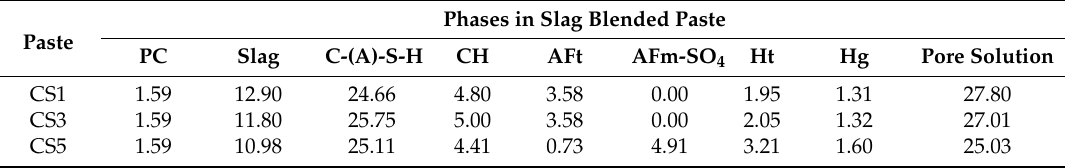
Figure 18. Relationship of solid phase volume for slag blended pastes with DoR of slag.